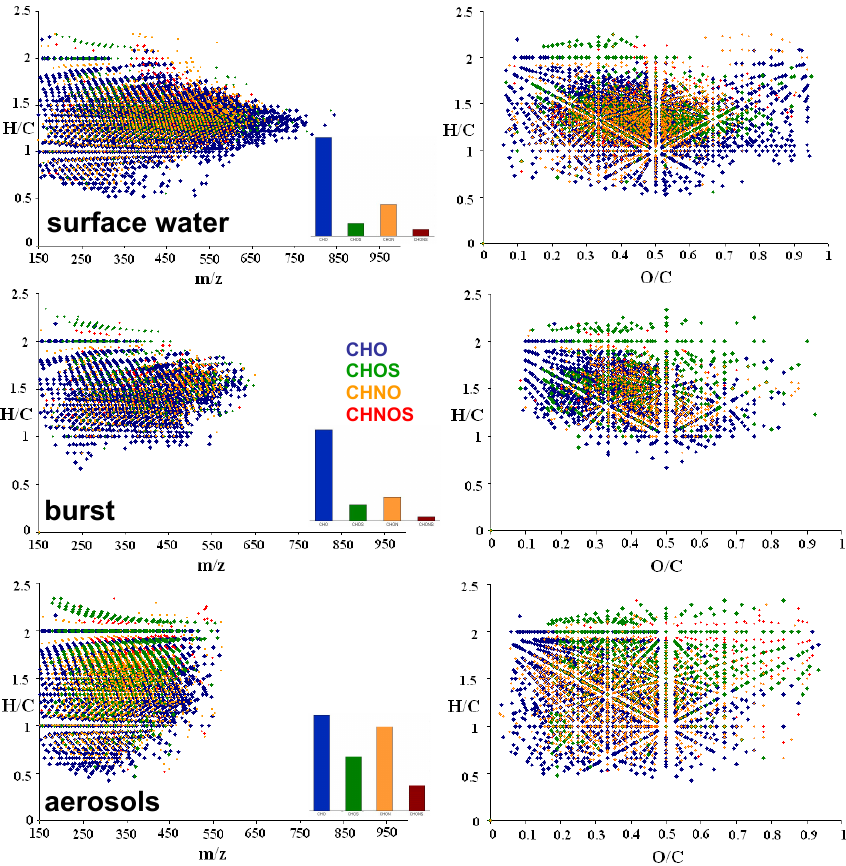
Fig. 3. Representation of the FTI-CRMS data as van Krevelen diagrams (right panels) with of all the surface all burst and all day aerosol cumulated mass data over the entire cruise ANT-XXV/1. Left panels represent the m/z dependant H/C values and the relative frequency histograms of CHO (blue), CHOS (green), CHNO (orange) and CHNOS (red) compounds.